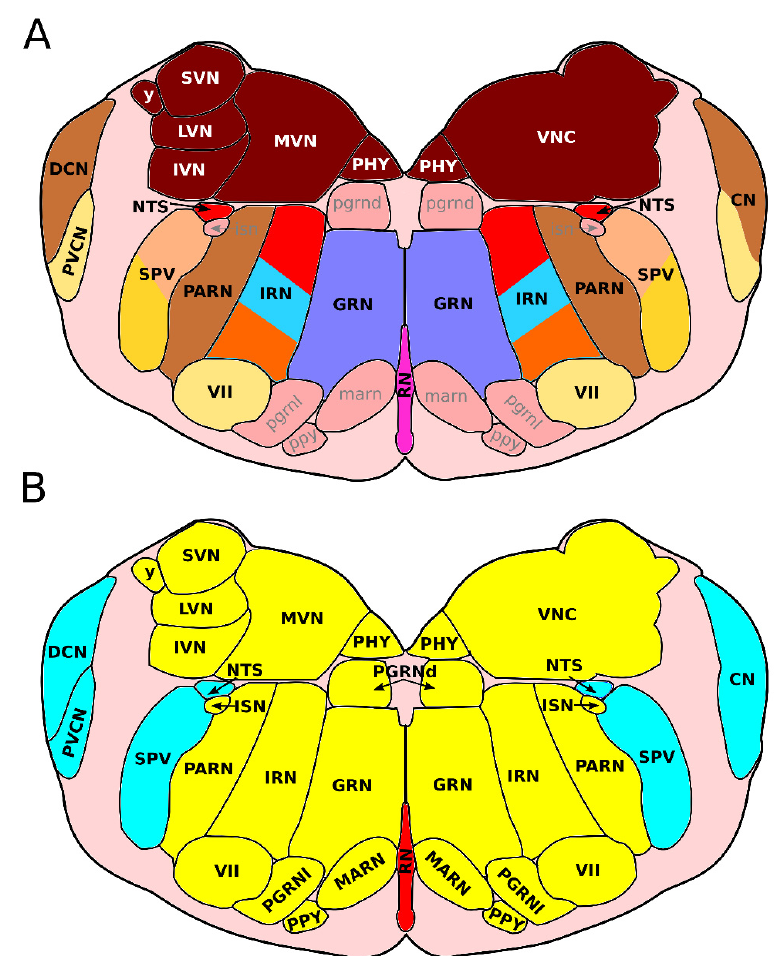
Figure 4. Location of the medullary nuclei in the rostral adult medulla oblongata (r7–r8). ( A ) Location of the medullary nuclei in the rostral adult medulla oblongata. Colors of the nuclei correspond to the colors used as in Figure 3. The origin of the neurons of some nuclei has not been described (e.g., pgrnd, marn, ppy) and are thus shown in grey. ( B ) Overview of the location and overall function of the medullary nuclei in the rostral adult medulla oblongata. Nuclei with a sensory function are depicted in blue, nuclei with a motor function are depicted in yellow, and nuclei with a behavioral function are depicted in red. Overviews are based on anatomical reference atlases from the Allen Brain institute [43].